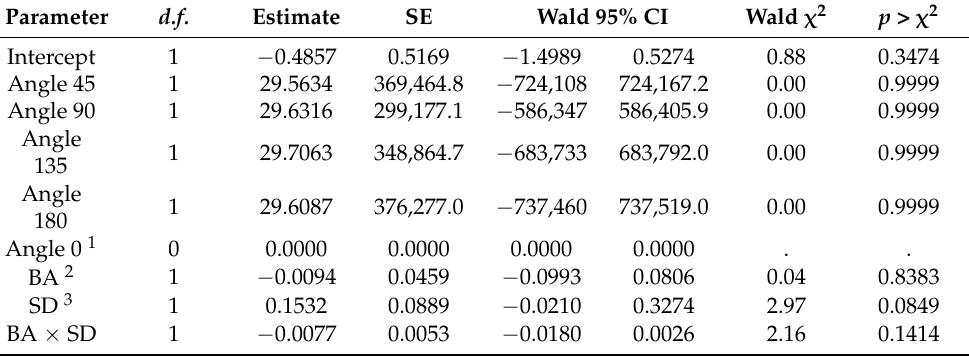
Table 5. Parameter estimates for generalized linear model results of synthetic bat echolocation playback response within an anechoic chamber to detector angle ( ◦ ) and simulated clutter variation represented by basal area (m 2 /ha) and stem density (stem count) for the probability of receiving an echo pulse, Blacksburg, VA, USA, 2016. Detectors recorded in full spectrum (see text for details). Parameter